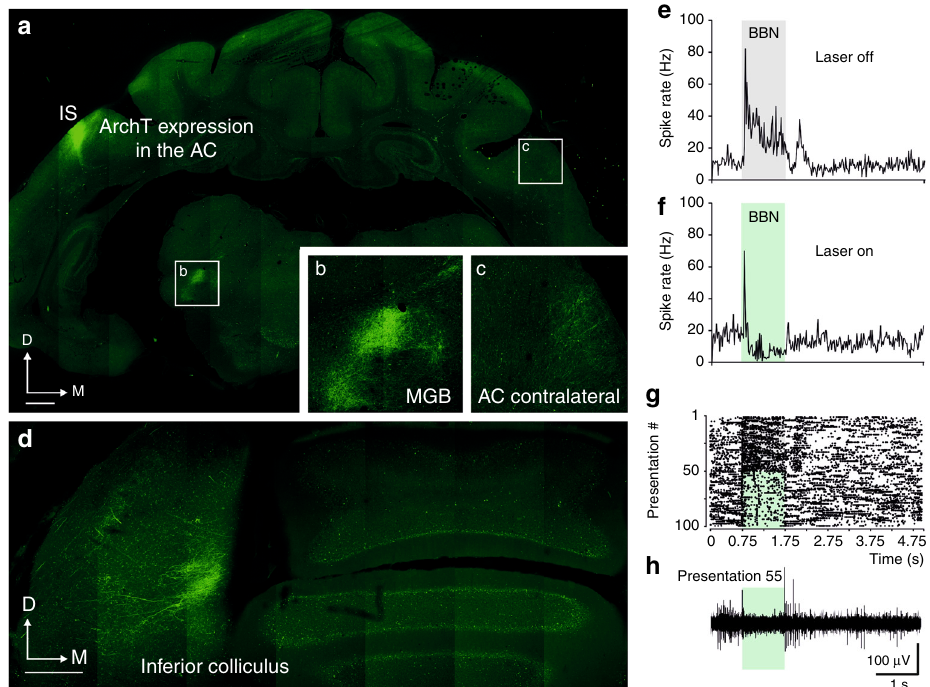
Fig. 2 Optogenetic suppression of ferret A1. a ArchT-GFP expression in a coronal view of the auditory cortex and thalamus of a ferret brain (F1431) transfected with the AAV8-CaMKII-ArchT-GFP construct. IS injection site. b , c Higher magni fi cation views of the corresponding boxed regions in ( a ). d GFP-labeled axons and terminals in the inferior colliculus originating from transfected neurons at the injection site shown in ( a ). e – h Neural activity recorded in a different animal (F1804) from a representative A1 unit expressing ArchT under the CaMKII promoter in response to 1000 ms bursts of broadband noise (BBN, gray bar) presented either alone ( e ) or paired with a 1000-ms light pulse ( f ) (green bar). ( e ) and ( f ) show 20 ms binned peristimulus time histograms. g The corresponding dot rasters for this unit grouped into laser-off (top half) and laser-on presentations (bottom half). h Activity recorded during a single presentation (#55 of the raster plot) with BBN paired with laser illumination (green) is shown in the bottom panel. Activation of ArchT by laser illumination resulted in suppression of the unit ’ s sound-evoked response ( t test, t 4 = 6.584, P = 0.001), including a loss of its offset response. Comparable spike rate to that found before BBN/laser illumination was observable as early as 0.5 s after laser offset ( t test, t 4 = 2.271, P = 0.086). Auditory cortical cells continued expressing ArchT 30 months after the viral construct injections. Behavioral testing took place over a